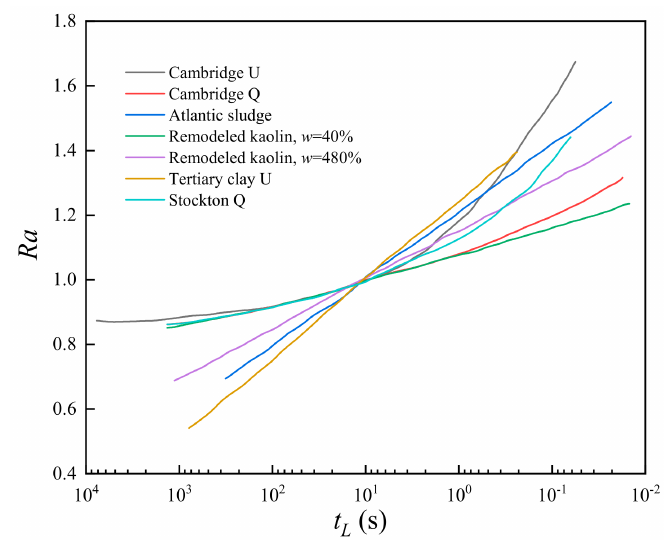
Figure 7. The ratio of dynamic strength to static strength versus loading